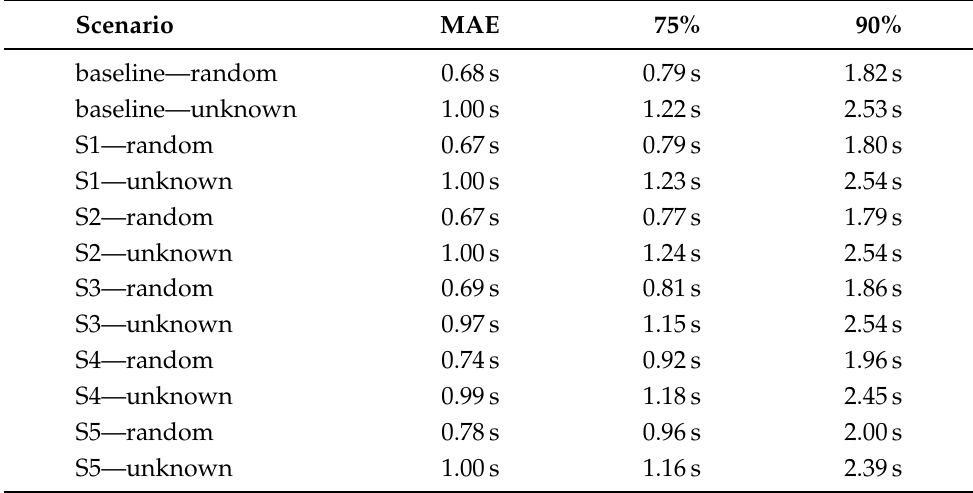
Table A3. Feature set